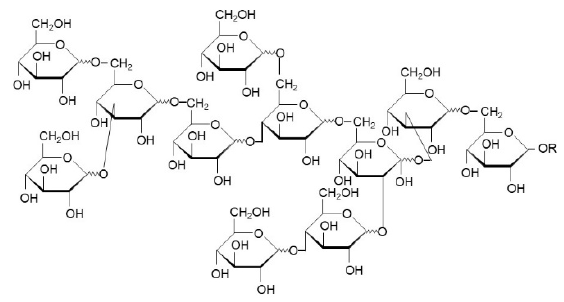
Figure 1. Schematic representation of the polydextrose structure.